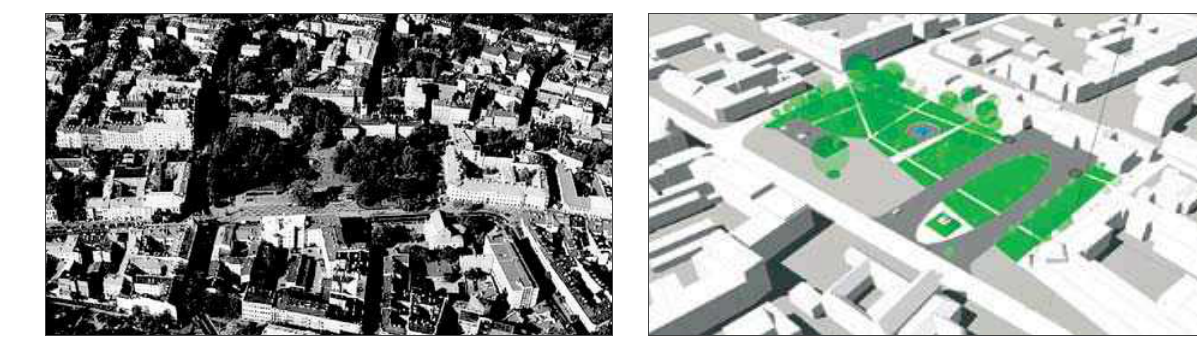
19 pav. Liublino (Lenkija) centrinės viešosios erdvės Skver Litewski dabartinis vaizdas Fig. 19. contemporary view of the public space Skver Litewski in Lublin (Poland)